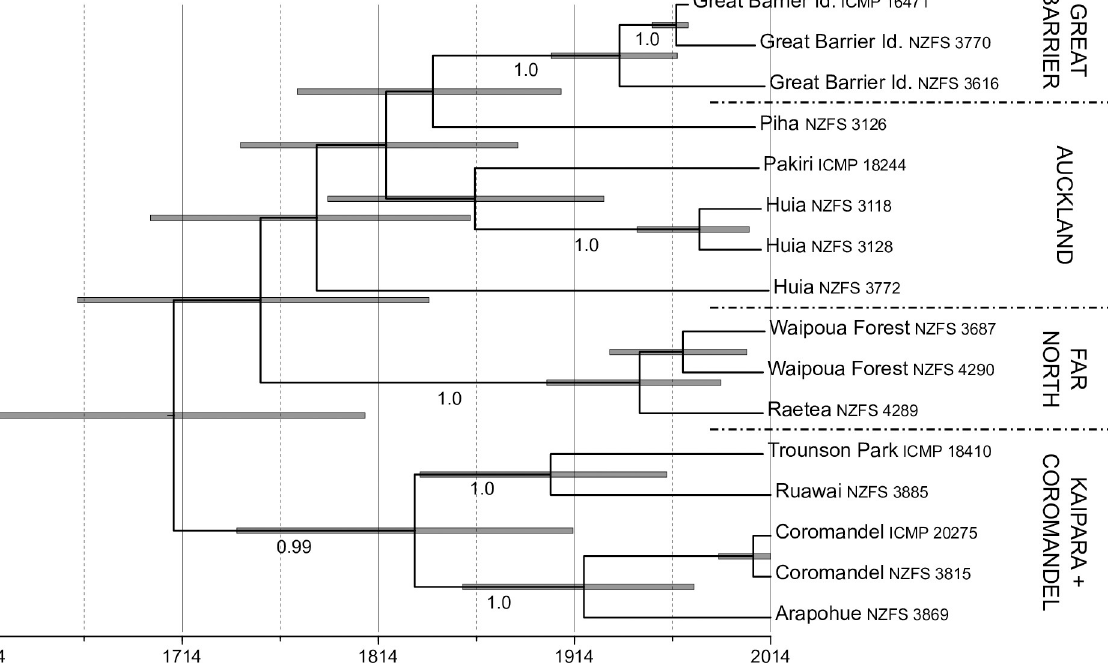
Fig 4. Time-calibrated phylogeny from the sequential analysis of sampled P . agathidicida mitochondrial genomes. Branch lengths are proportional to time with grey bars indicating the 95% highest probability densities. Terminals are labelled with collection location and accession number; four broad genetic groups are also